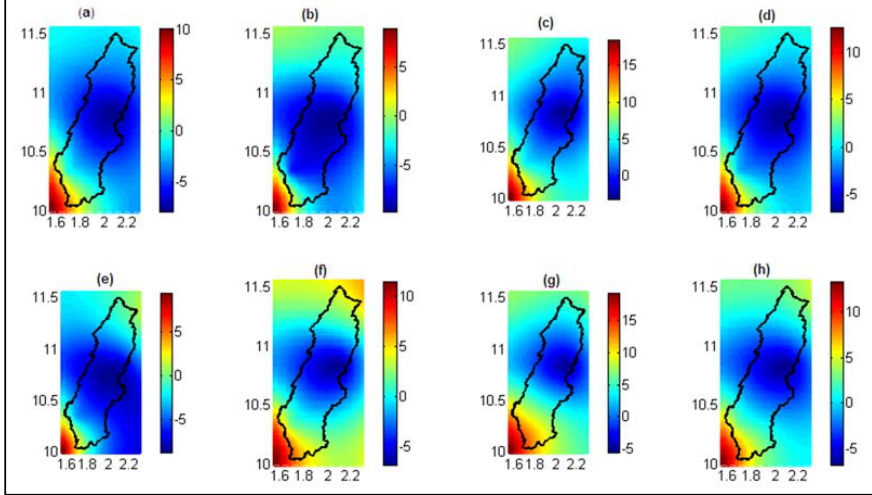
Figure 6 . Changes in the onset of the rainy season (%) compared to the reference period a : RCP4.5 ‐ 2011–2040; b : RCP4.5 ‐ 2041–2070; c : RCP4.5 ‐ 2071–2100; d : RCP4.5 ‐ 2011–2100; e : RCP8.5 ‐ 2011–2040; f : RCP8.5 ‐ 2041–2070; g : RCP8.5 ‐ 2071–2100; h : RCP8.5 ‐ 2011–2100.